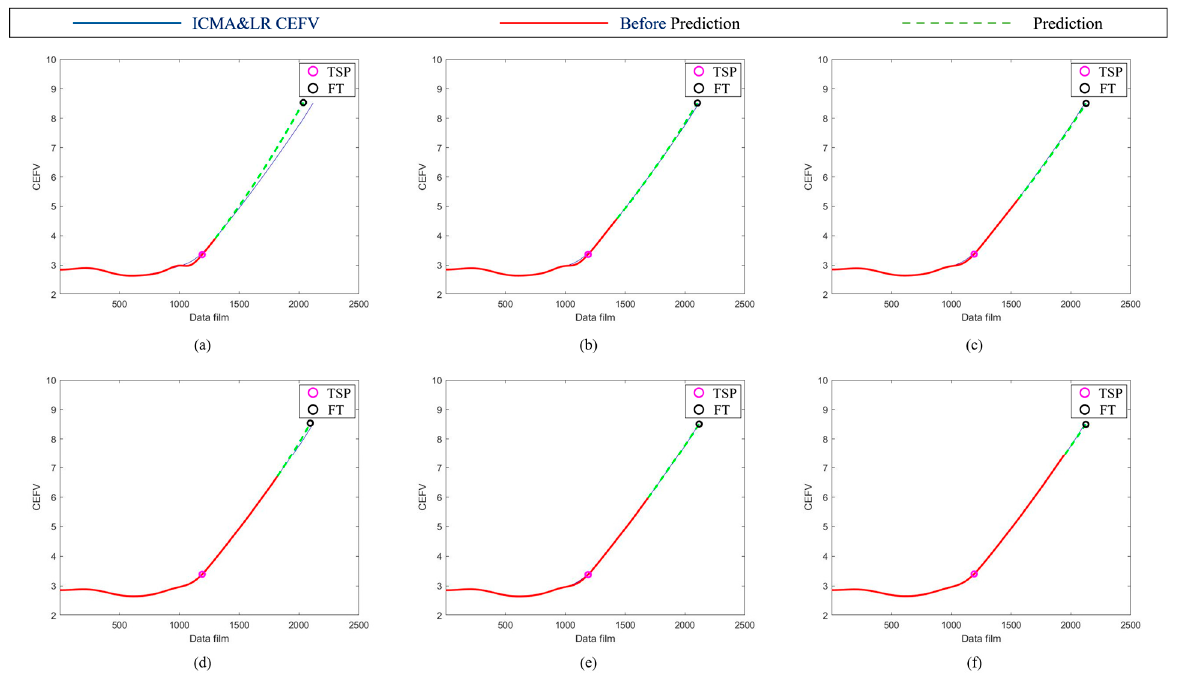
Figure 15. Trajectories of bearings’ health indicators using norm values. The trajectory was generated